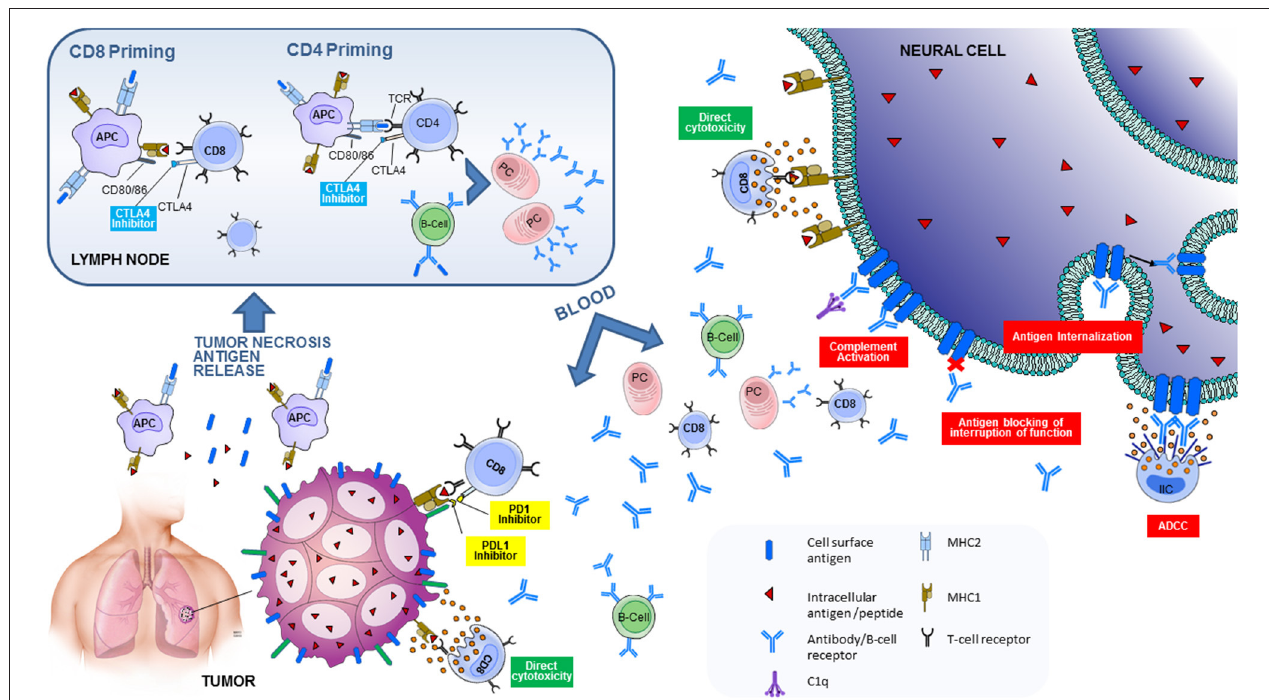
FIGURE 1 | Pathogenic mechanisms involved in neurological immune related adverse events triggered by immune checkpoint inhibitors. Tumor antigens released from necrotic tumor cells are captured, processed into peptides by antigen-presenting cells (APC) that present them on major histocompatibility complex (MHC) molecules to the naïve T-cells in the lymph nodes. The T-cell receptor (TCR) engages with MHC molecules on the APC. Co-stimulatory signals from the interaction between CD28 on T-cells and B7 (CD80/86) on the APC are necessary to activate a naïve T-cell. This results in activation of CD8 cytotoxic T-cells against tumor-specific antigens, and CD4 helper T-cells that will help activate B-cells that have engaged via their B-cell receptor their cognate antigen and push them into antibody-producing plasma cells (PC). There are also inhibitory signals, or immune checkpoints, that regulate T-cell activation. CTLA4 on T-cells competes with CD28 for B7 binding. The interaction between CTLA4 and B7 is an inhibitory signal for T-cells. CTLA4 blockade therefore leads to enhanced T-cell activation in the lymph node. CD8 cytotoxic T-cells and plasma cells travel to the tumor. PDL1 expressed by the antigen-specific T-cells binds to PD-L1 expressed by tumor cells, leading to an inhibitory signal. Blockade of PD1/PD-L1 leads to enhanced T-cell activation on a tissue level. CD8 cytotoxic T-cells and plasma cells also travel to the nervous system. CD8 cytotoxic T-cells directed against neural antigens (that are aberrantly expressed by the tumor) will cause direct cytotoxicity and cell death. Antibodies directed against cell-surface neural antigens (aberrantly expressed by the tumor) can cause cell damage via several different pathways: by complement activation or antibody dependent cellular cytotoxicity (ADCC), by antigen internalization (modulation), or by antigen blocking with interruption of its function. Reproduced with permission from Sechi and Zekeridou ( 35). Suggested mechanisms of neurological autoimmunity in the context of ICI